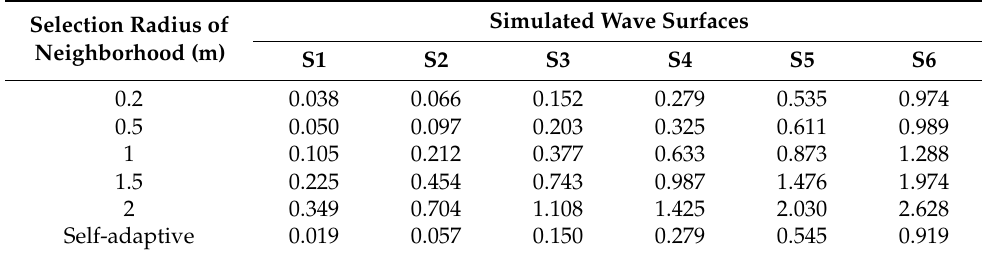
Table 8. Root mean square error of wave surface aspect estimation.